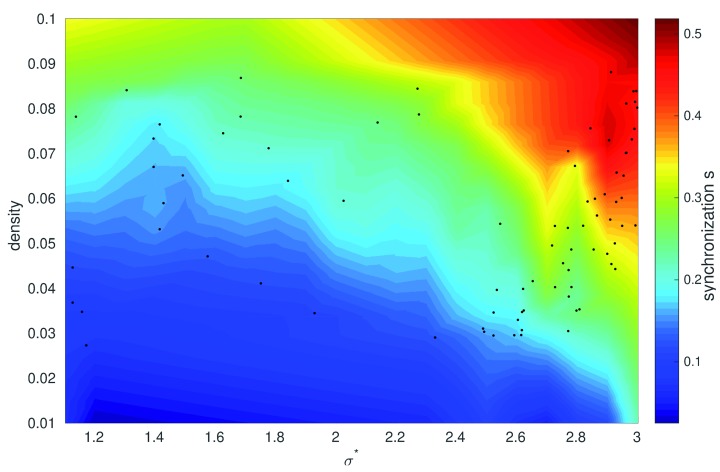
Synchronization
s dependent on network topology: density and distribution width
σ*.The experimentally attested distribution width for weights in cortical tissue
8 is
σ* = 2 − 3.5, with a mean at 3. We achieve higher synchronization
s in the lognormal region, also dependent on density, but no synchronization in the Gaussian (region of low width) (
σ* < 1.5), except close to maximal connectivity. Black dots signify actual measurements. There seem to be no abrupt transitions.